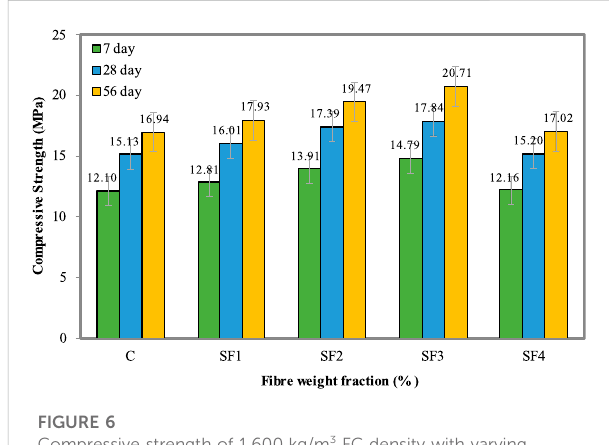
FIGURE 4 Compressive strength of 1,000 kg/m 3 FC density with varying weight fractions of SF.